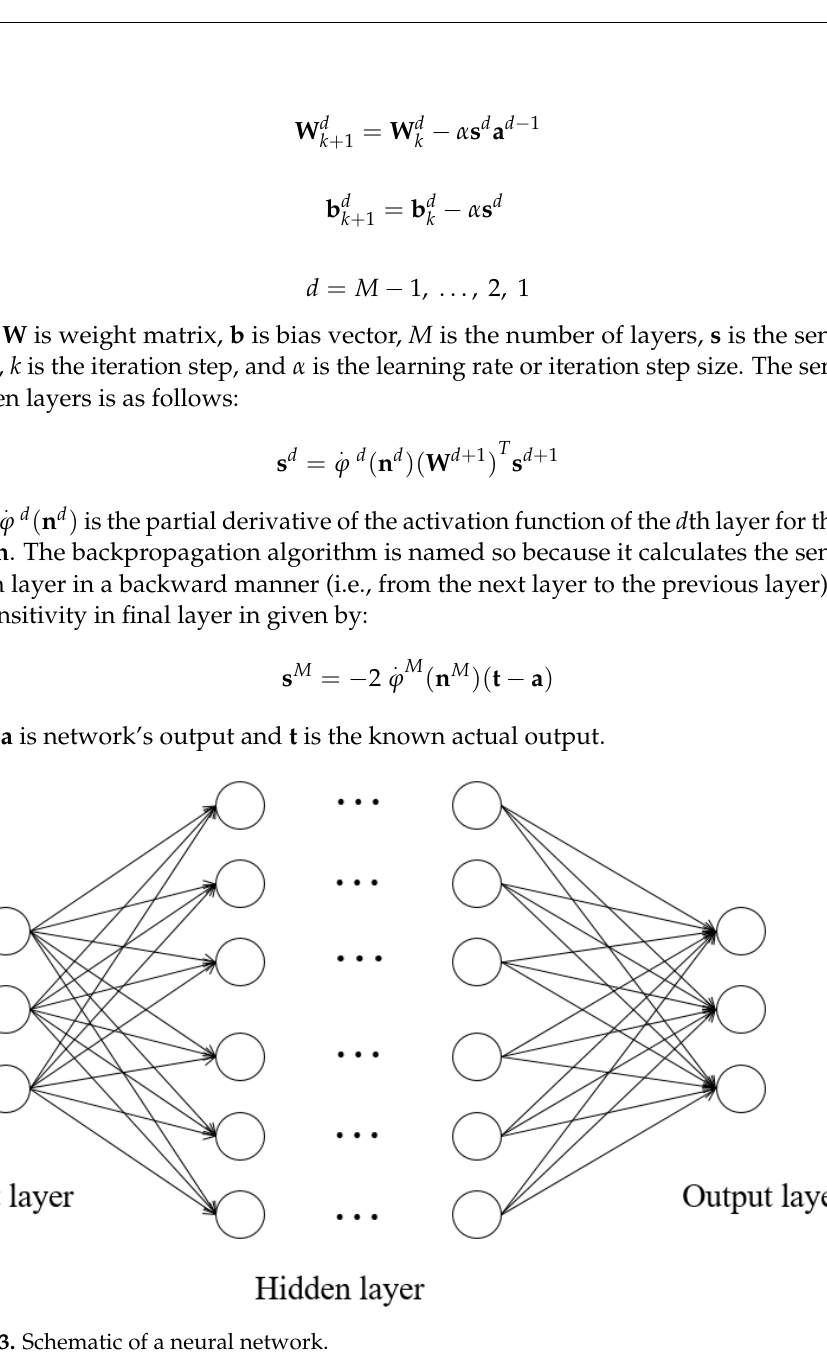
Figure 3. Schematic of a neural network.